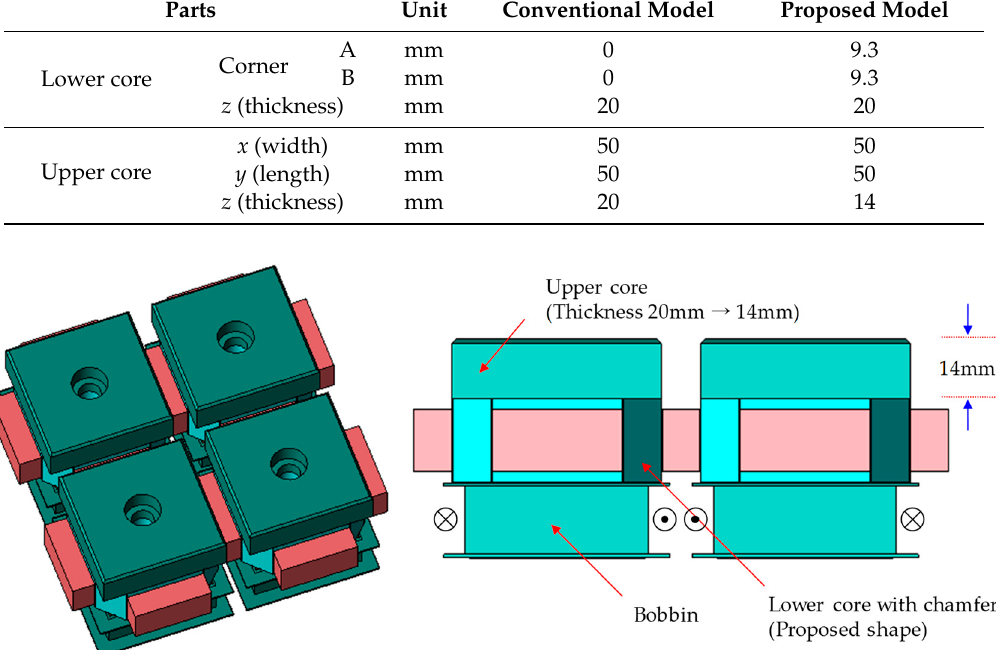
Table 3. Dimensional changes of the upper and lower cores in the proposed model.